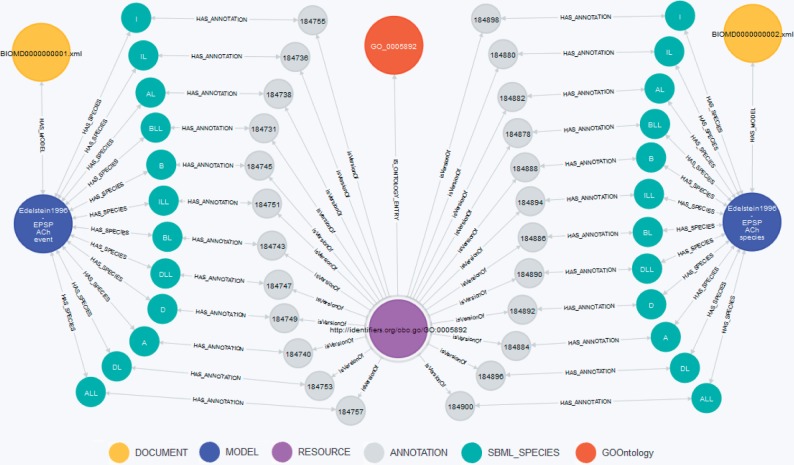
Visualization of Query BM3. The centered node (purple) is the requested annotation GO:0005892 (acetylcholine-gated channel complex). This node is connected to the orange node representing the GO term within the GO. The green nodes represent the species linked to the GO:0005892 annotation, the blue nodes represent the models ‘Edelstein1996—EPSP ACh event’ (BIOMD0000000001) and ‘Edelstein1996—EPSP ACh species’ (BIOMD0000000002). Documents are displayed as yellow nodes. Nodes in gray represent annotation containers as stated in the SBML specification (4) and do not carry any meaning themselves.